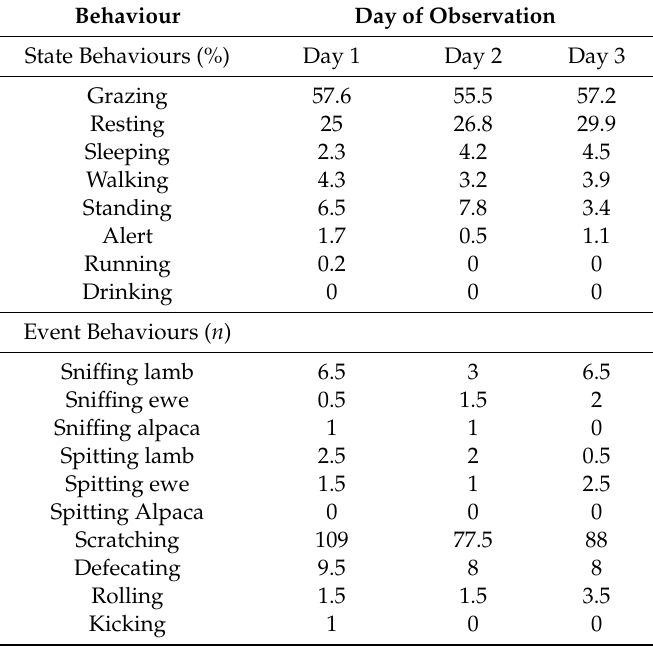
Table 4. Average time spent on state behaviours (%) and frequency of event behaviours (number) by alpacas ( n = 2) observed over a 3-day non-consecutive period. Observations occurred for 40 min out of every 60 min (divided into 2 × 20 min observation sessions) from 05:30 to 19:30 h. Refer to Methods Section 2.3 for definition of